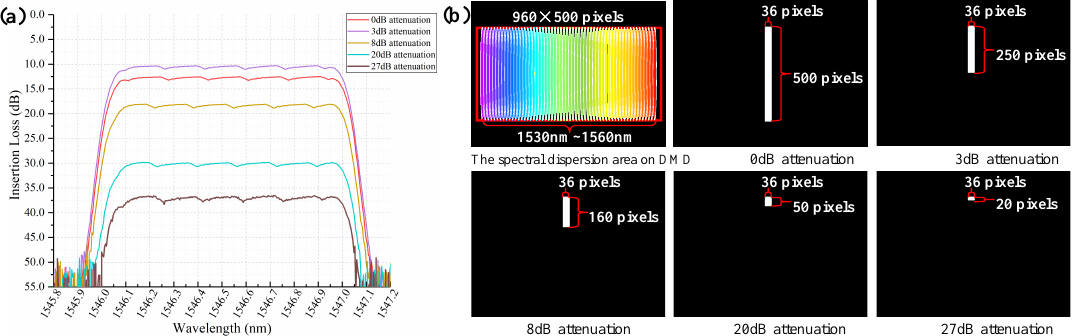
Figure 9. Optical power attenuation of the optical filter and the corresponding binary